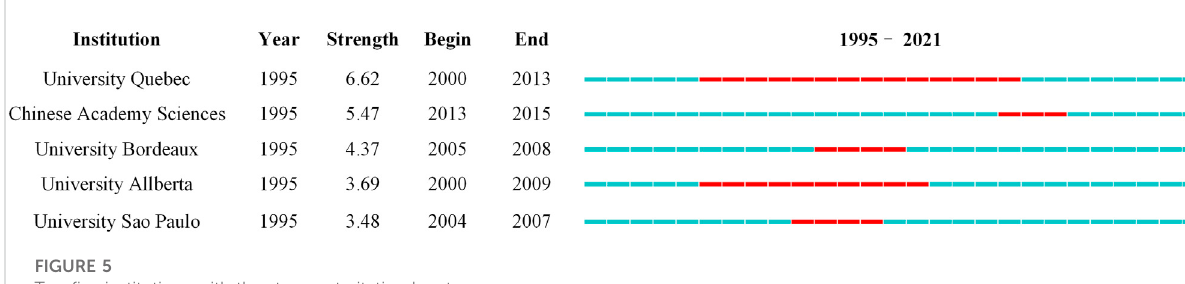
FIGURE 5 Top fi ve institutions with the strongest citation bursts.